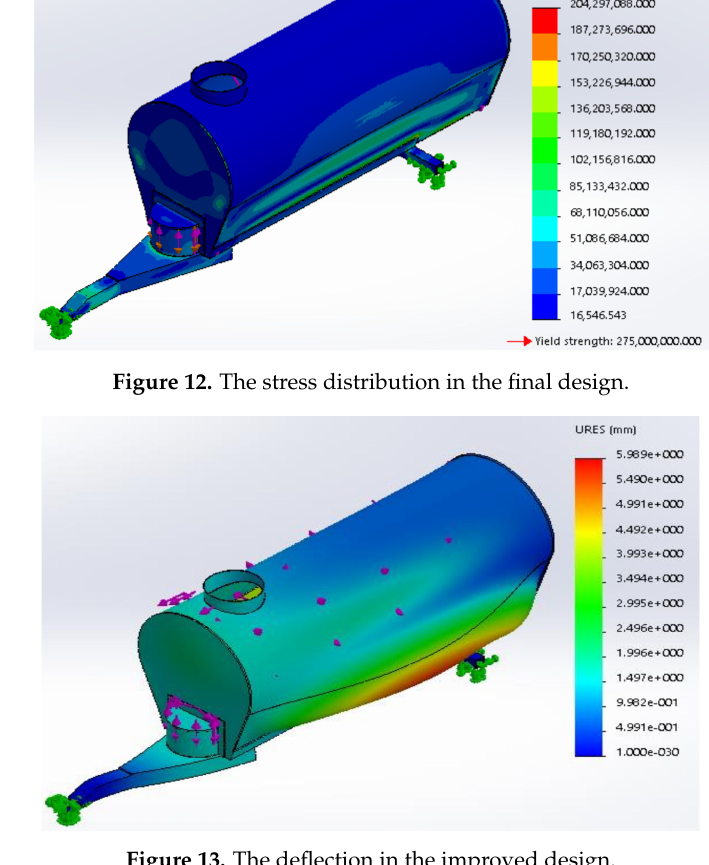
Figure 13. The deflection in the improved